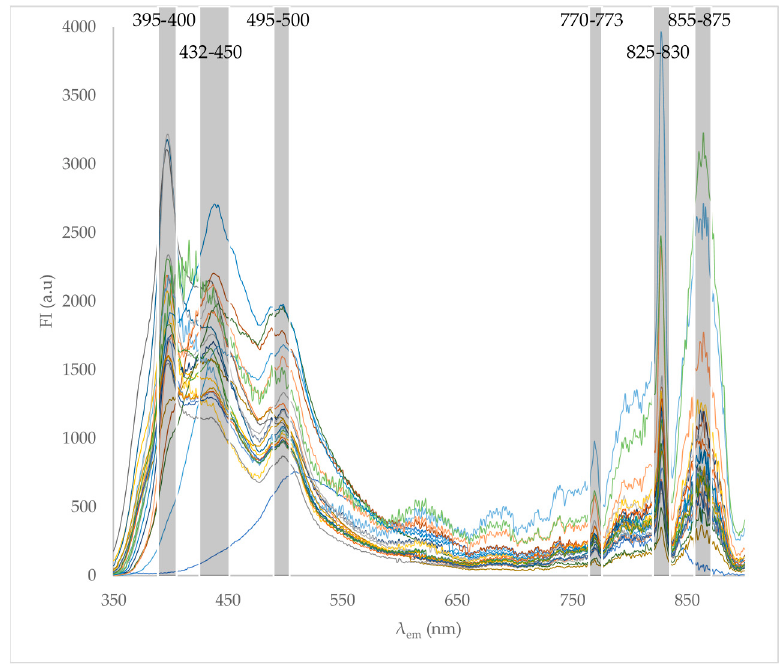
Figure 1. Emission spectra for all freshly opened beer samples (1–24). The six shaded areas indicate regions of varying intensity that are believed to be specific to the fluorophore compounds in beer and therefore can be used to differentiate between beer samples.